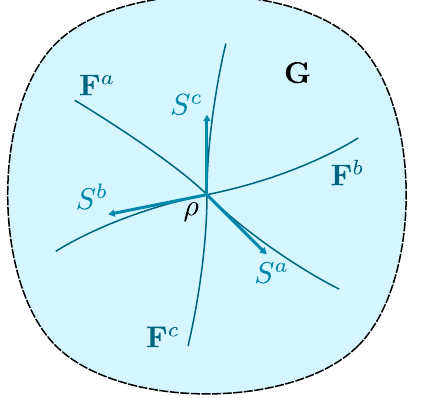
FIG. 3. The space represents G , a mother family of density operators. The true density operator is denoted as ρ . Parametric submodels are represented by curves in G that intersect at ρ . Each score S σ is a tangent vector that quantifies the “ velocity ” of a density-operator trajectory in a certain